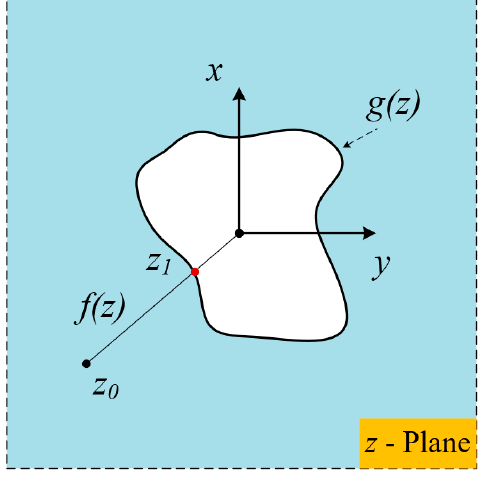
Figure 1. Schematic diagram of an opening in an infinite elastic plate.